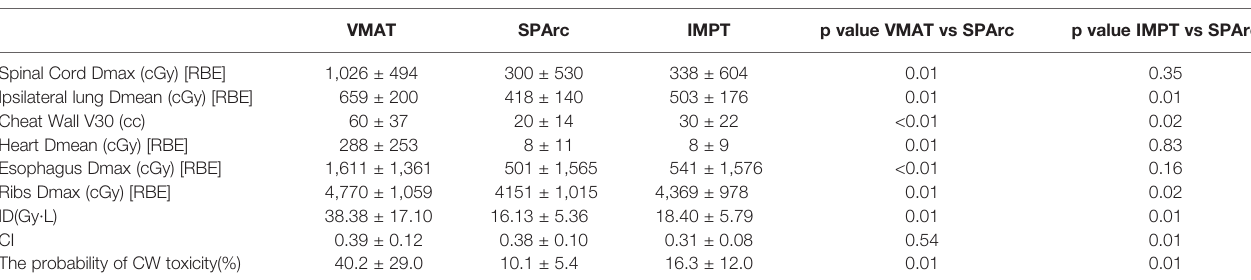
TABLE 2 | Dosimetry results for the three planning modalities VMAT SPArc IMPT p value VMAT vs SPArc Spinal Cord Dmax (cGy)